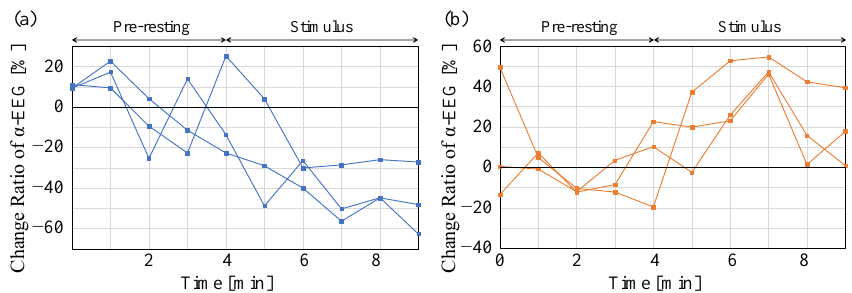
Figure 11. Examples of the time-transient change rate of α-EEG of ( a ) one subject indicated by blue minus signs (Subject 5, Figure 9) categorized into Group-1 with white noise, and ( b ) one subject indicated by minus signs (Subject 5, Figure 9) categorized into Group-2 with murmuring river sound, respectively. In these time-transient waveforms, the initial four minutes are for the pre-resting time without any sound reproduction, while the latter five minutes are for the time of sound reproduction. Note that in these figures the three trials in the experiment are indicated as three lines. In these results, the α-EEG of the subject decreased by 4 to 9 min after the presentation of white noise in Figure ( a ), while increased by 4 to 9 min after the presentation of the murmuring river sound in Figure ( b ).